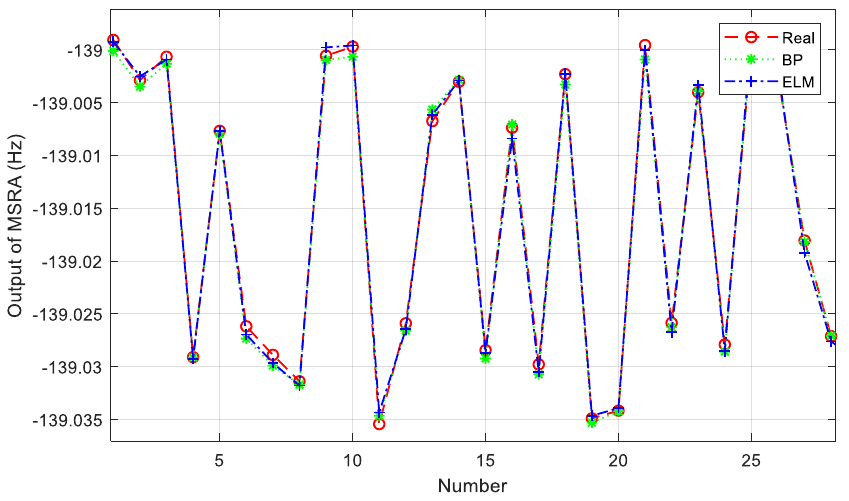
Figure 5. ELM network structure. Twelve sets of MSRA static output data at room temperature and 0 g were selected for offline training. After using a modified wavelet threshold function for noise reduction, nine of the data sets were used as the training set and three as the test set. The same number of neurons in the hidden layer was chosen in the same modelling platform to build the BP neural network and ELM, respectively. A random selection of 30 samples from the test set is shown in Figure 6.